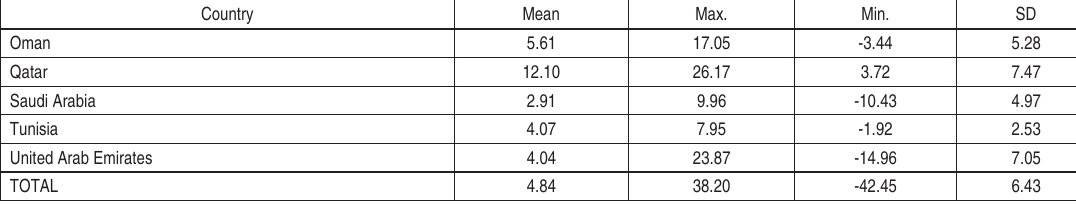
Table A.1 (cont.). Summary Statistics of key variables over 1980–2013